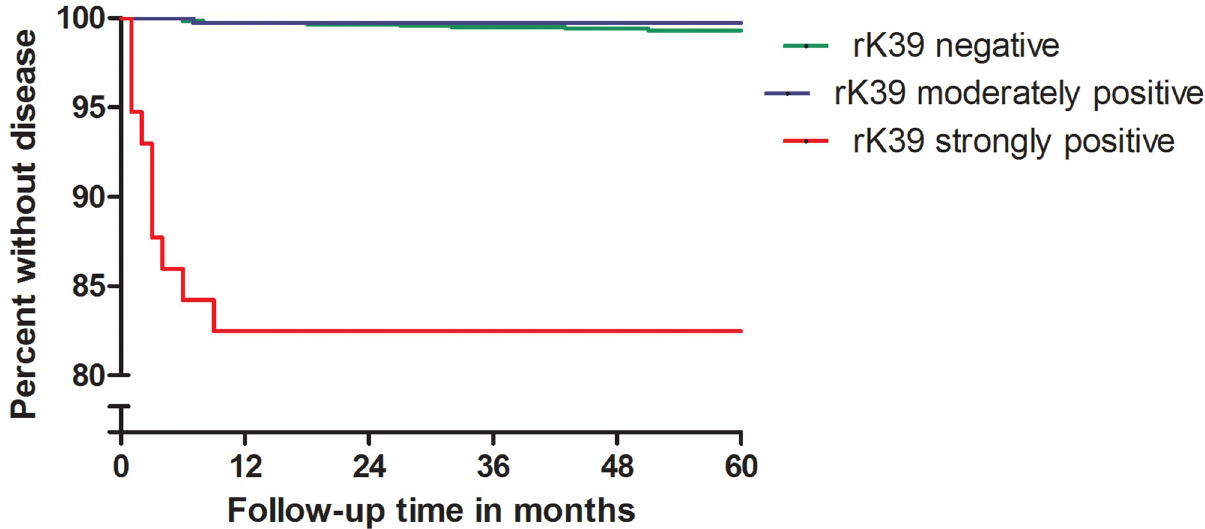
Fig 2. Risk of progressing to disease as a function of initial rK39 ELISA level.